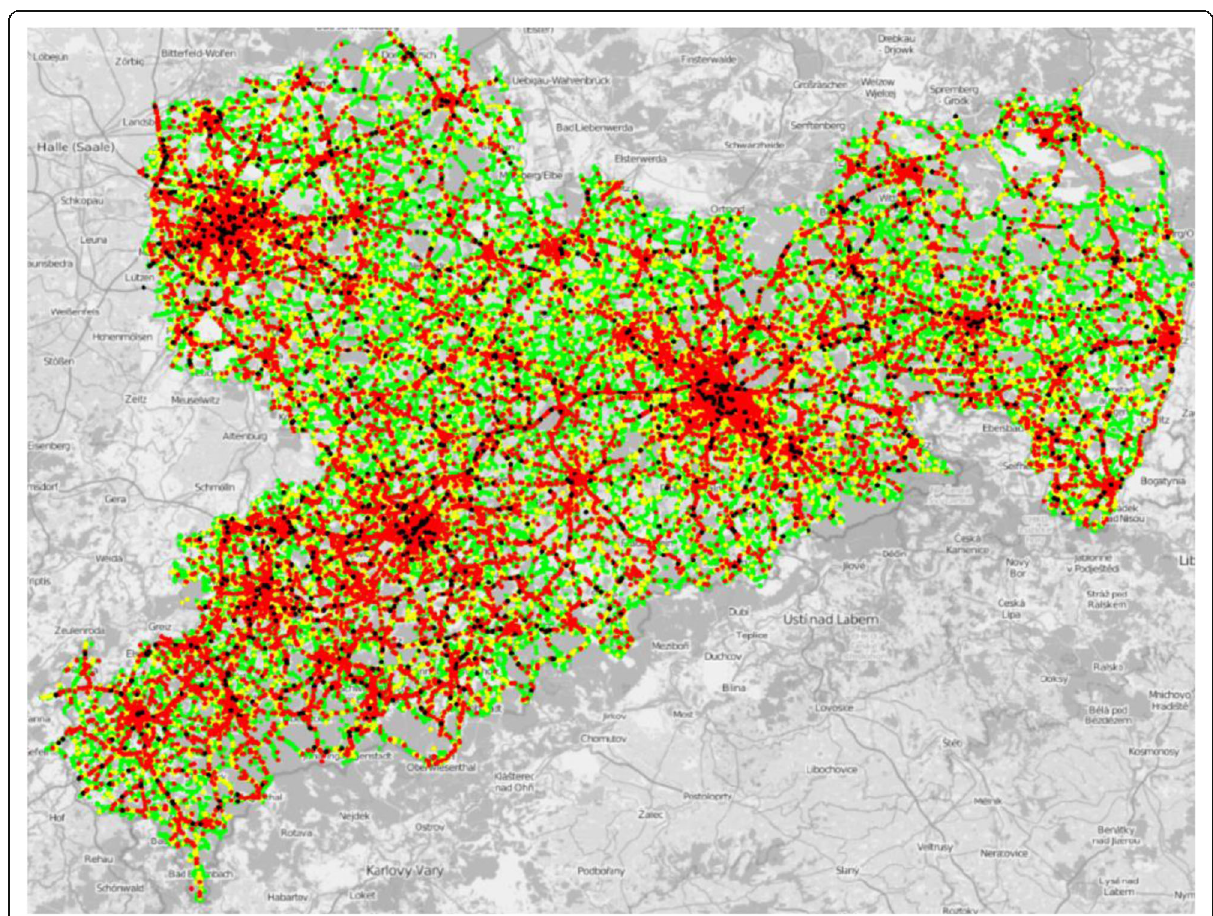
Fig. 4 Area-wide analysis: Police-recorded accidents in Saxony (Source: Christian Erbsmehl Fraunhofer IVI